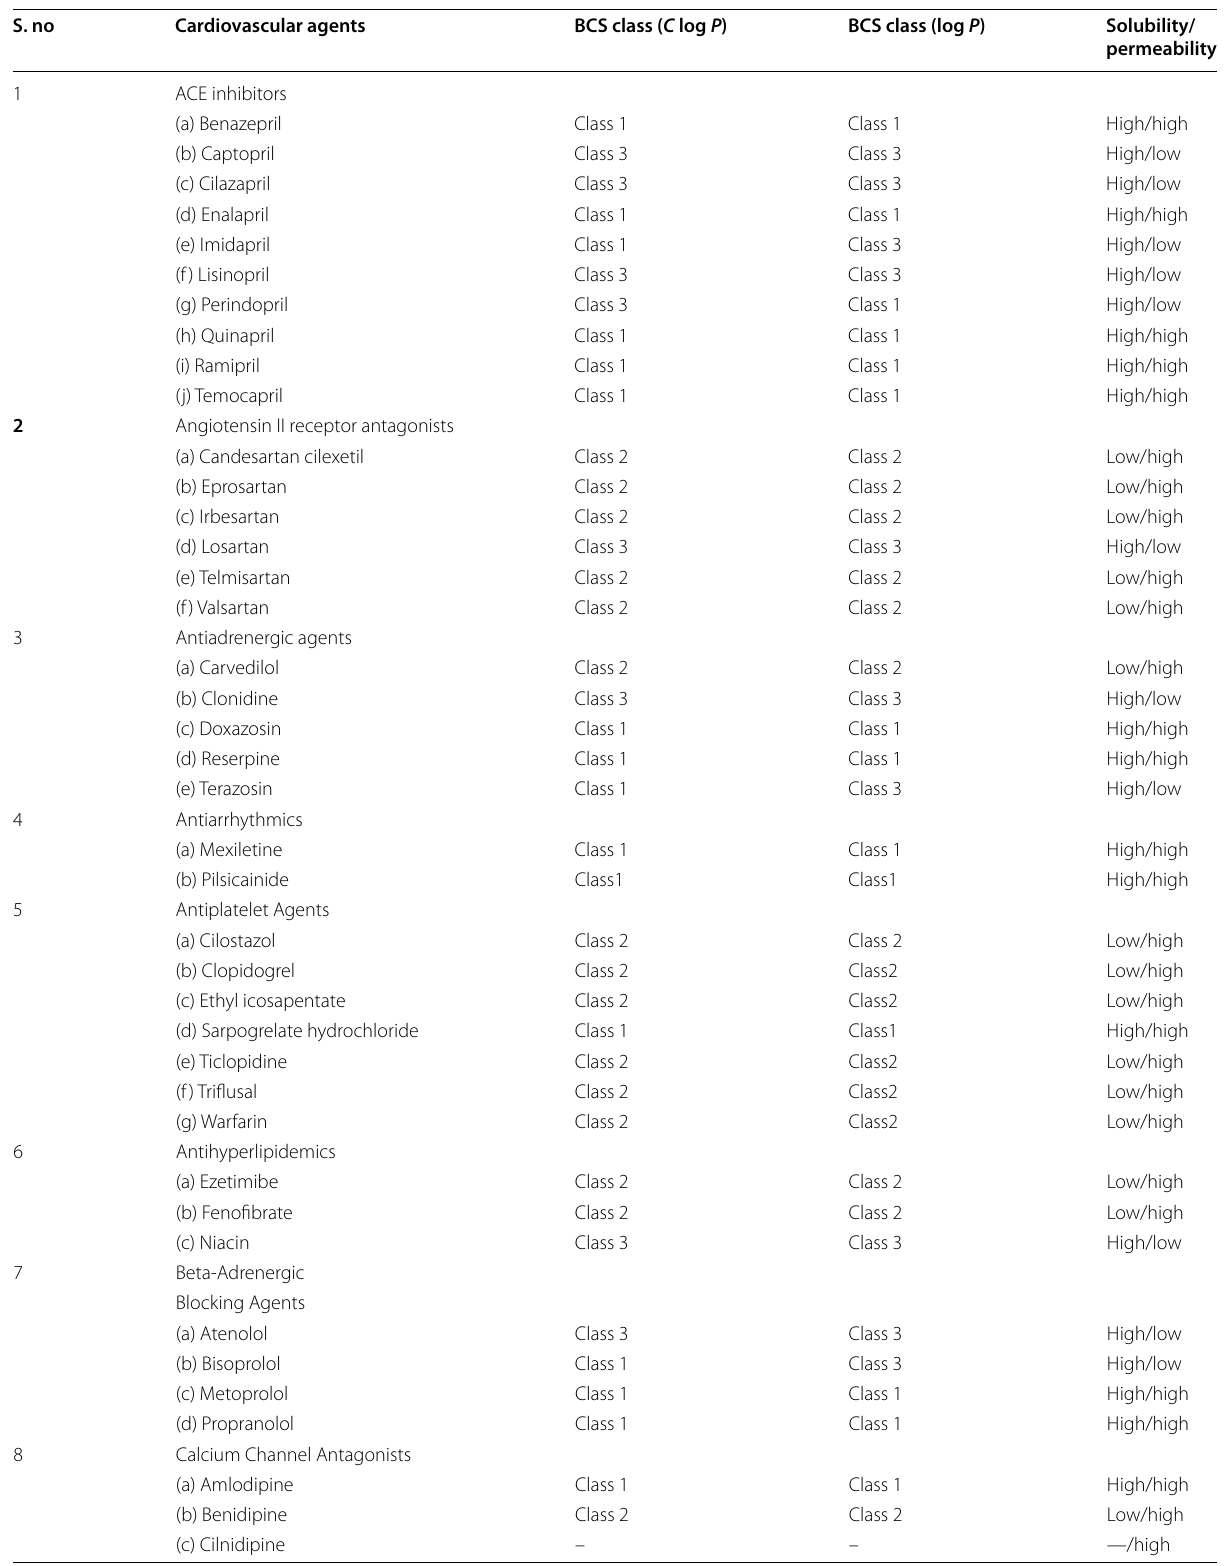
Table 2 Cardiovascular Drugs under BCS